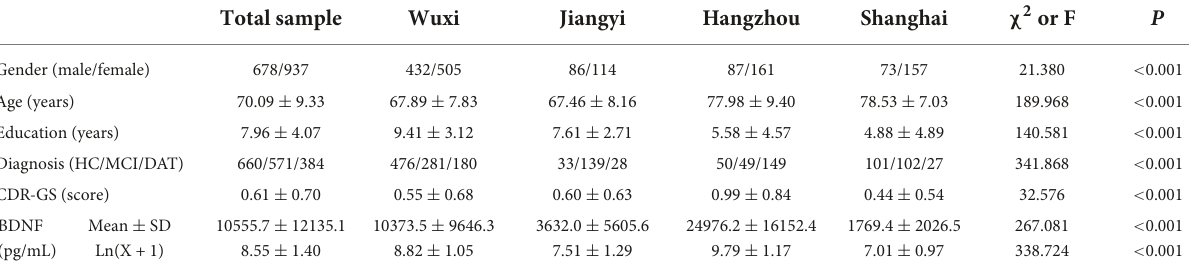
TABLE 1 Sample source and basic